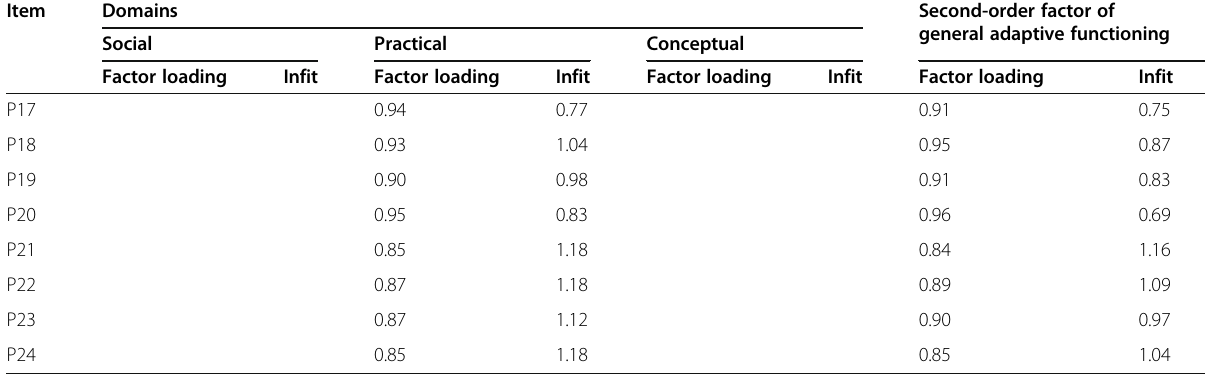
Table 3 Parameters of confirmatory factor analysis and item response item analysis (Continued)